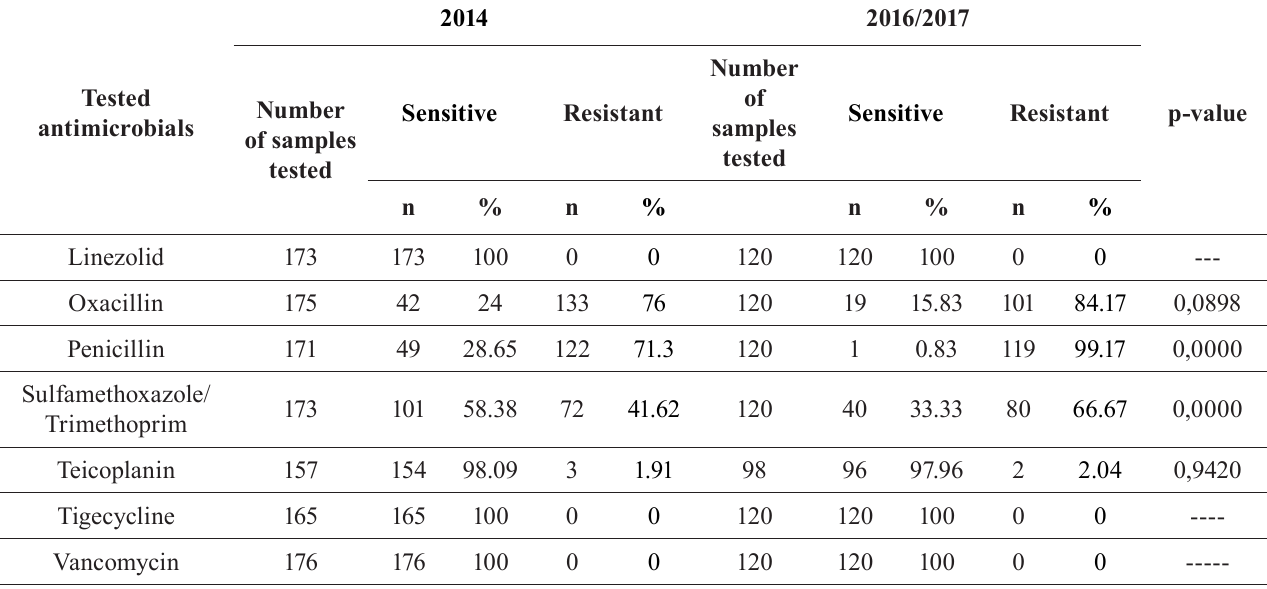
*Test for the difference between two population proportions, significance level adopted